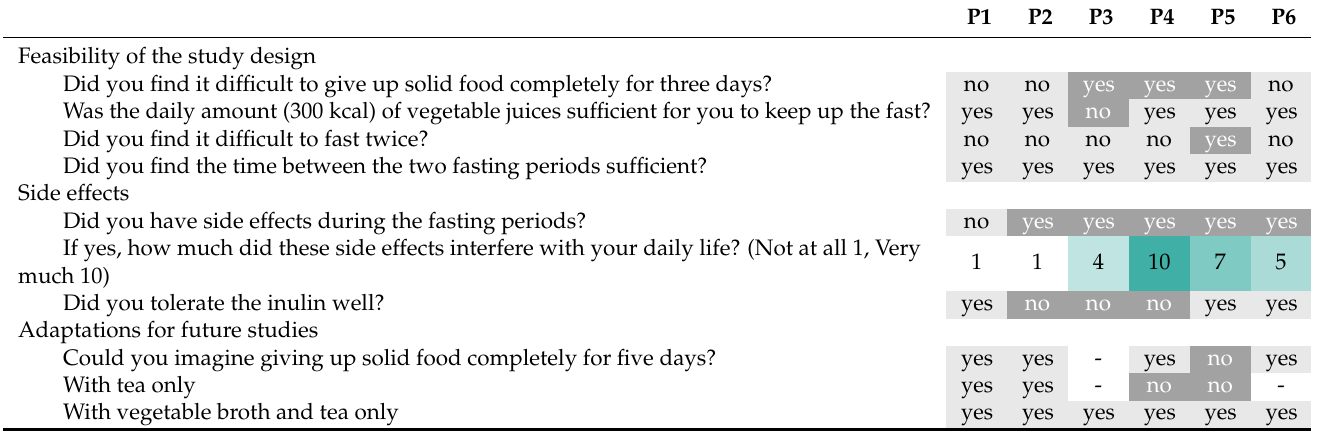
Table 1. Detailed information about study feasibility for each of the six participants. “yes” and “no” responses are color coded to differentiate favorable (light grey) from poor (dark grey) tolerance of the study design. Scoring answers are color coded with a gradient green scale from favorable (transparent/score = 1) to poor (green/score = 10) tolerance. P1 P2 P3 P4 P5